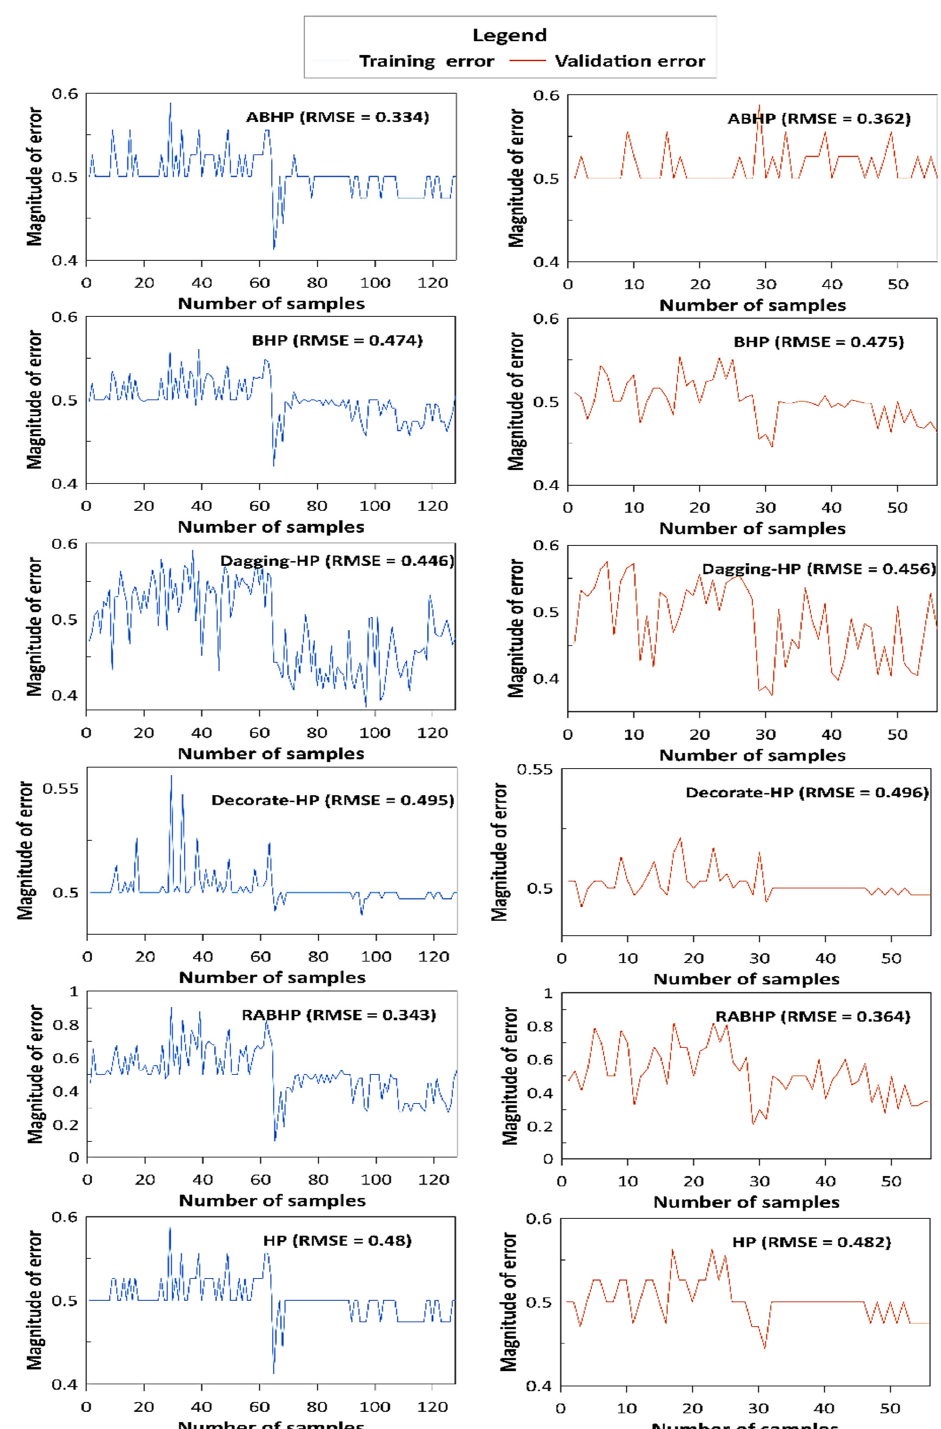
Figure 5. Training and validation errors of the modeling process.